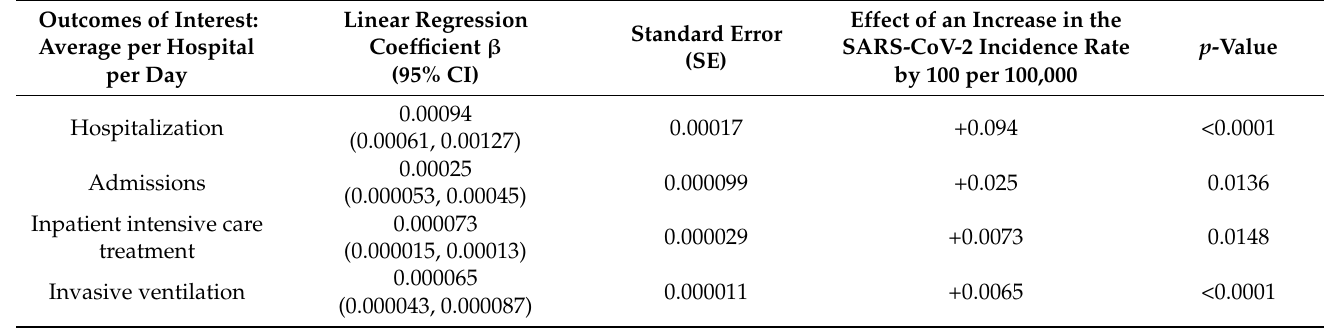
Table 1. Regression models for different outcome parameters: Relationship between the daily average numbers of hospitalizations, admissions, inpatient treatment in ICU, and patients requiring invasive ventilation and the SARS-CoV-2 incidence rates among children and adolescents in